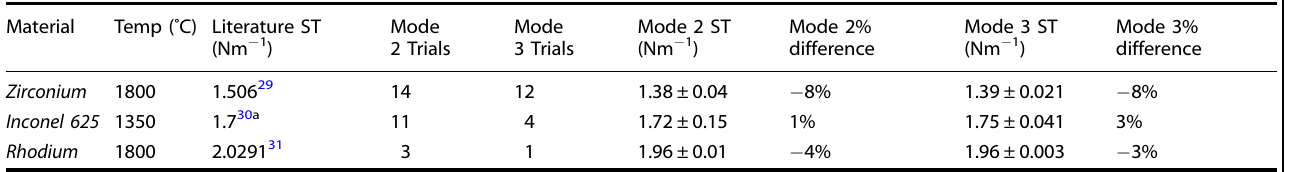
Table 2. Table of results using the Faraday forcing method for modes 2 and 3.